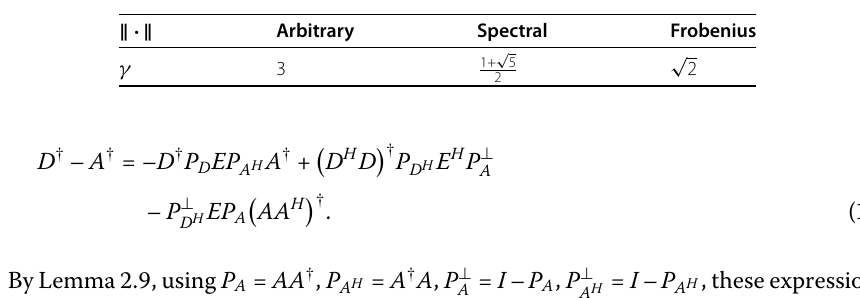
Table 1 Value options for